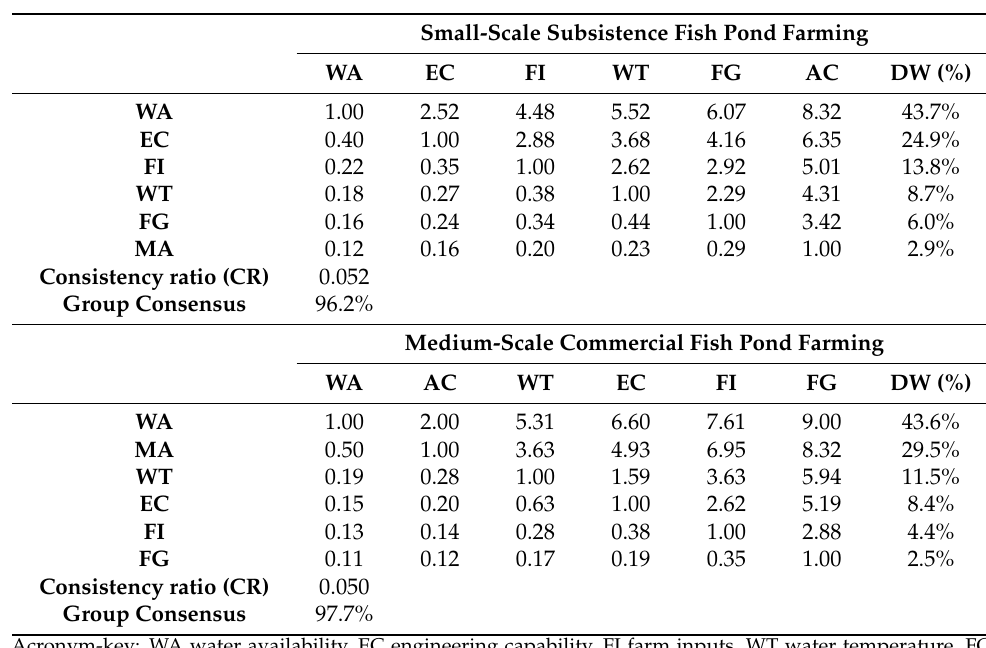
Table 4. Consolidated AHP-decision matrix with derived weights (DW) in